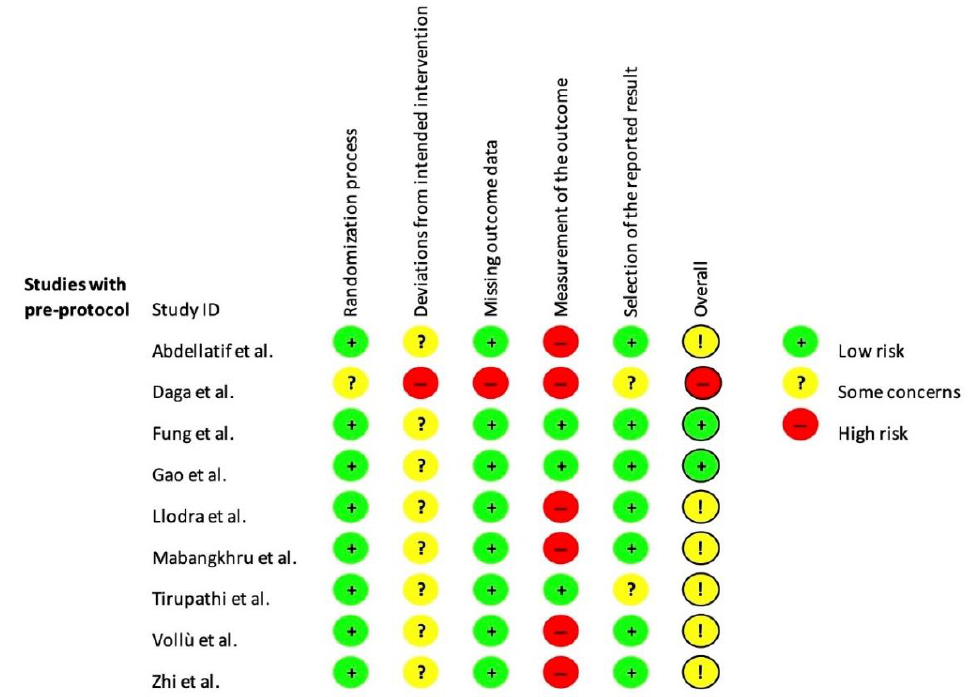
Figure 2. Risk of bias assessment of included studies using the RoB 2 [35 – 43].